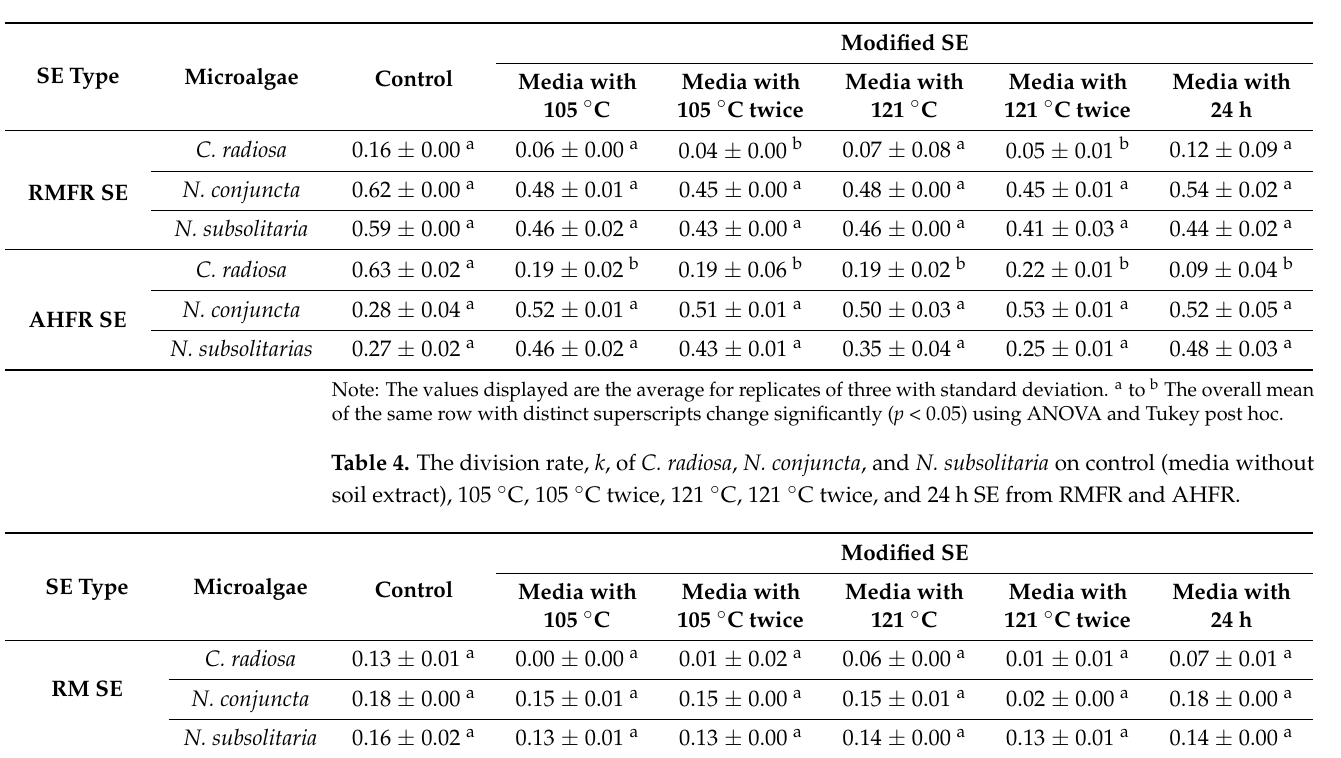
Table 3. The maximum OD of C. radiosa, N. conjuncta , and N. subsolitaria on control (media without soil extract), 105 ◦ C, 105 ◦ C twice, 121 ◦ C, 121 ◦ C twice, and 24 h SE from RMFR and AHFR.